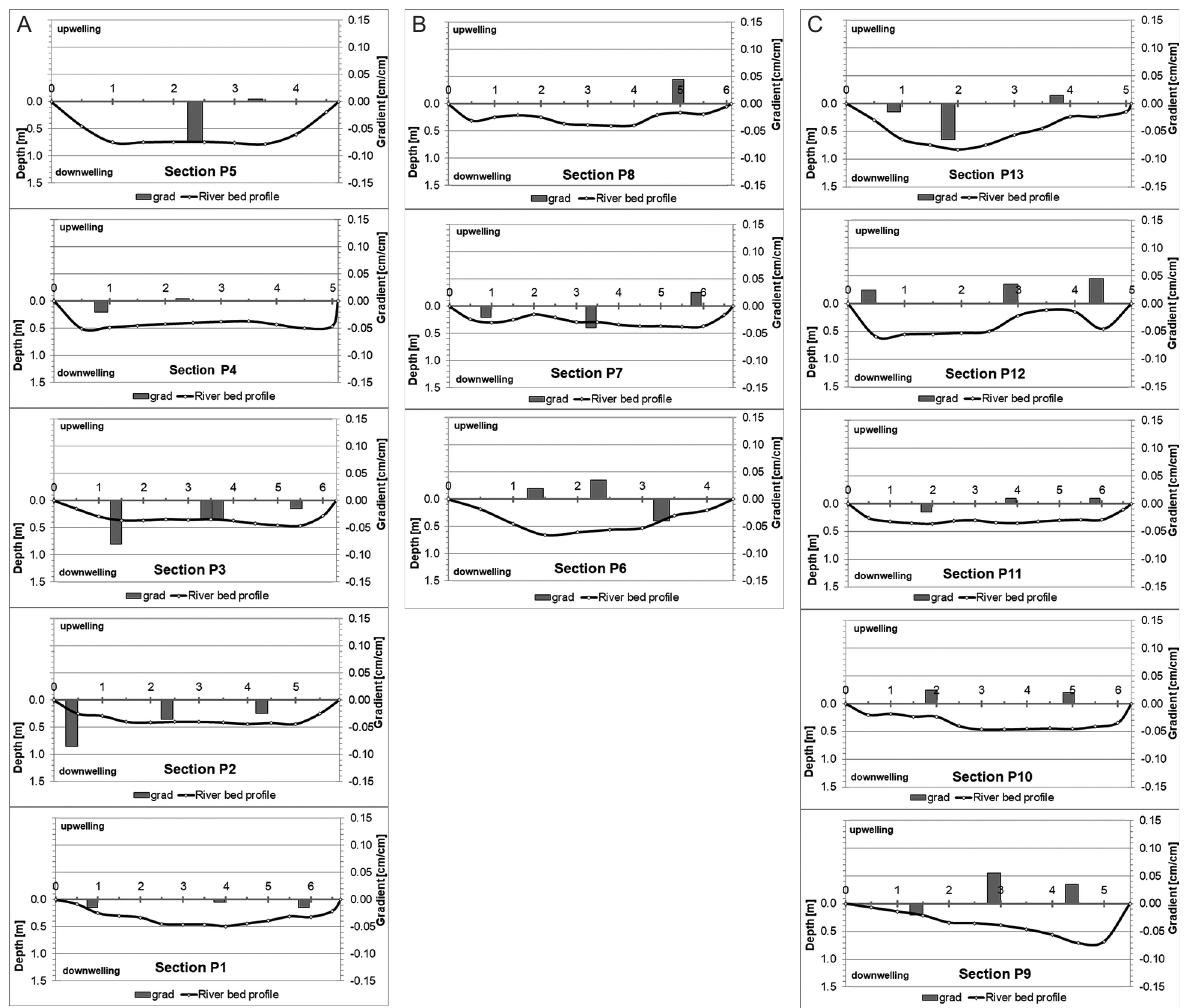
Fig. 11. A – Variability of hydraulic gradient in cross-sections along the Moszczenica river bed in the section with a predominance of downwelling, B – Variability of hydraulic gradient in cross-sections along the Moszczenica river bed in the transition zone between the dominant downwelling and upwelling, C – Variability of hydraulic gradient in cross-sections along the Moszczenica river bed in the section with a predominance of